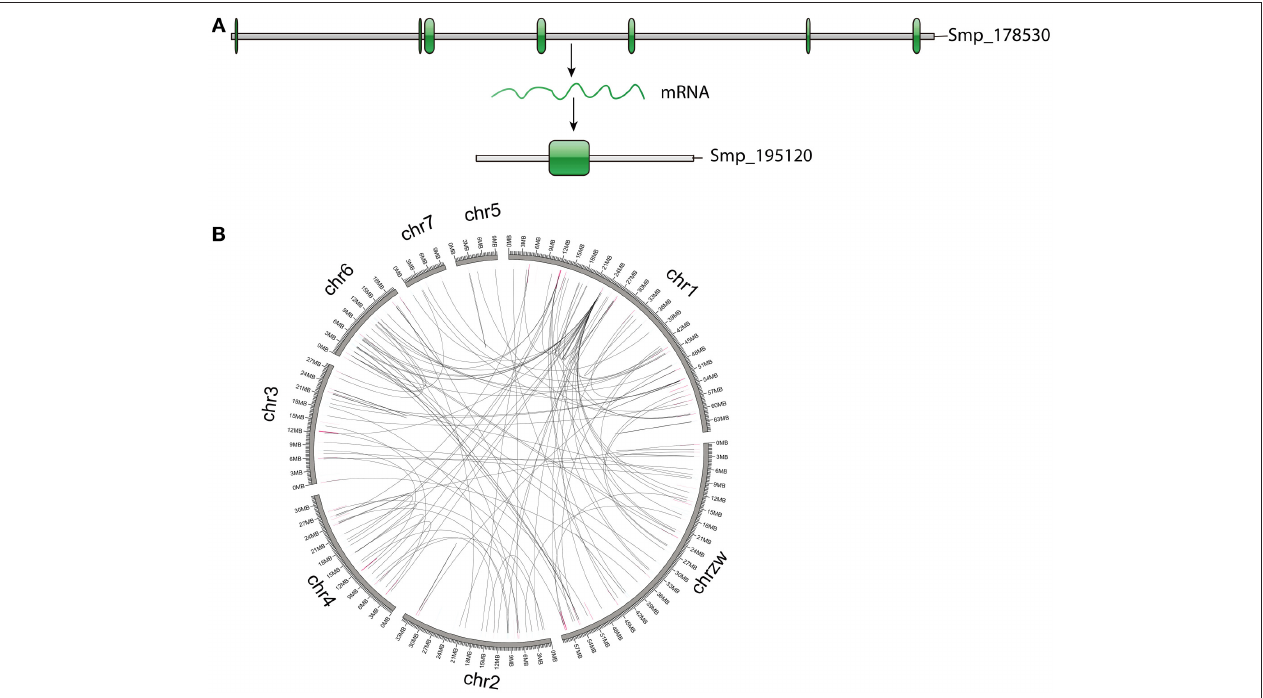
FIGURE 5 | Genes generated by retroposition mode. (A) An example of genes identified as retrogenes. The parental gene (Smp_178530) has multiple exons, while the retrogene (Smp_195120) only has one exon, implying an origin of retroposition. (B) Locations of retrogenes and their parental genes. The highlights represent locations of retrogenes (blue) and parental genes (pink).